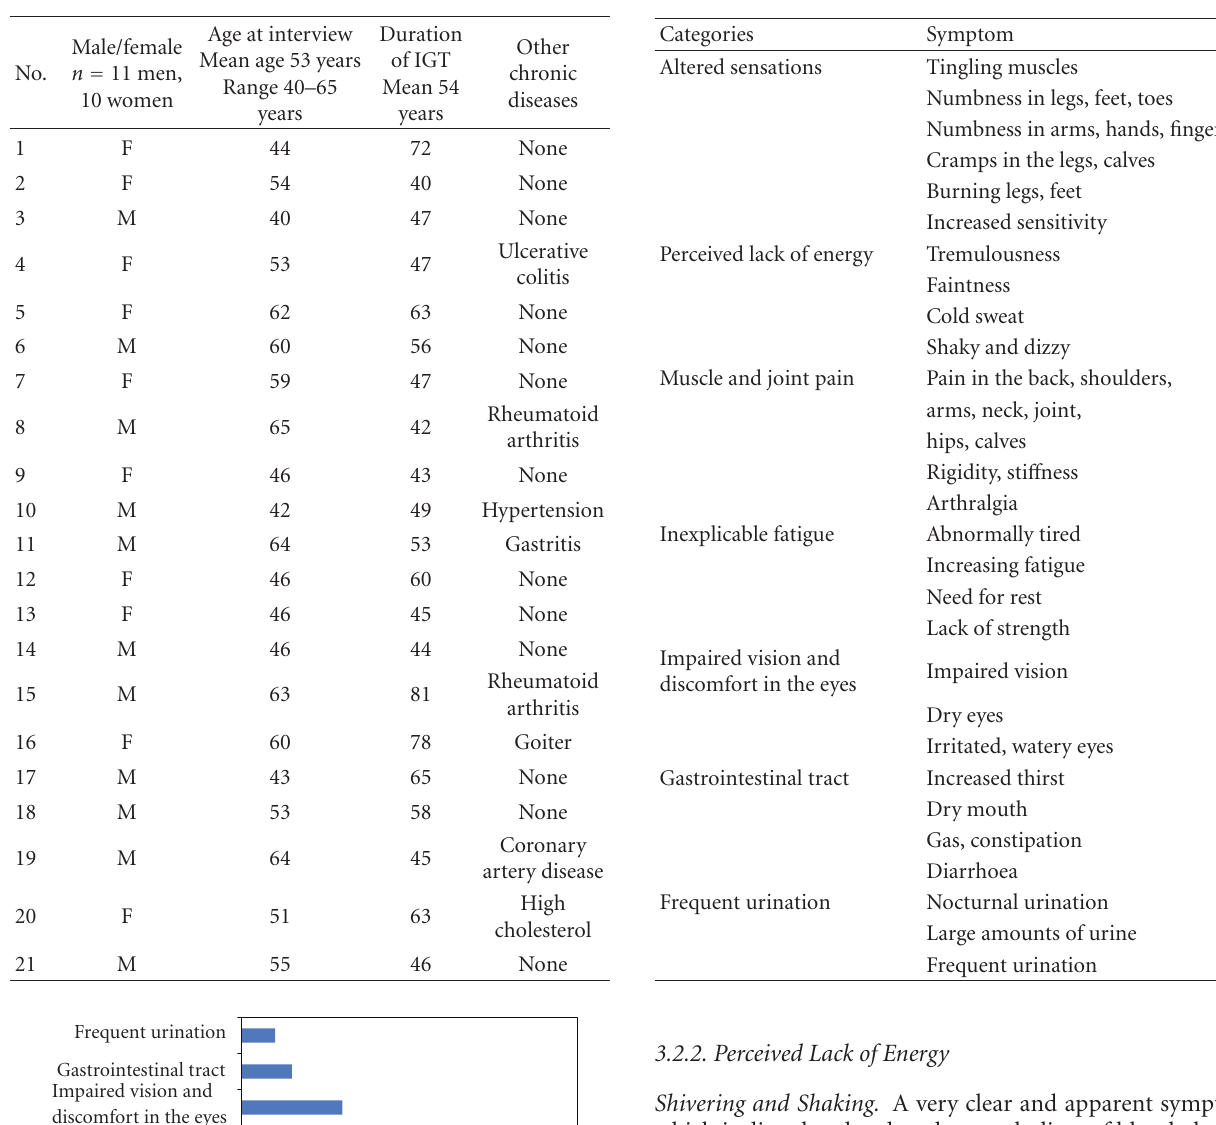
Table 1: Characteristics of the informants ( n = 21).